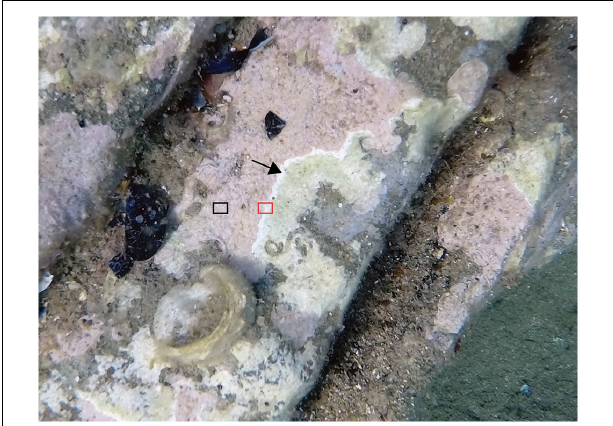
FIGURE 1 | Coralline White-Band Syndrome (CWBS) in CCA, Banyuls-sur-Mer, France. Two samples were taken from each diseased CCA: healthy-looking tissue (black rectangle) and diseased tissue (red rectangle). The black arrow points to the white-band characterizing the CWBS. Additionally, samples of healthy tissues were taken from CCAs showing no visible signs of